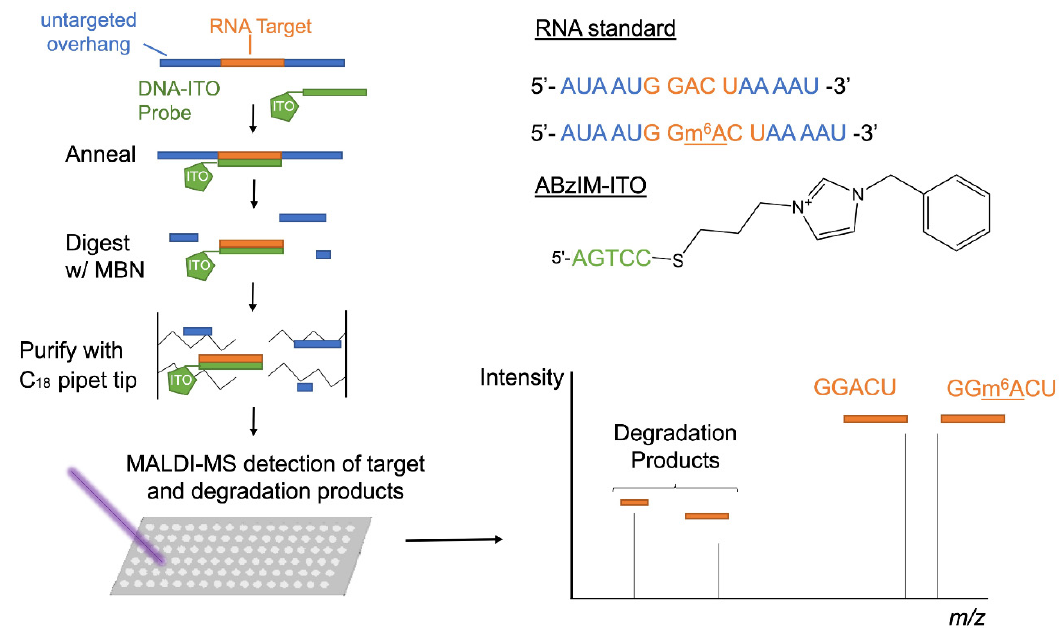
Figure 1. Schematic showing the workflow for the ITO-based nuclease protection assay including ITO probe–target annealing, MBN digestion, sample purification, and MALDI-MS detection of the liberated target sequence (GGACU or GG(m 6 A)CU) and target degradation fragments. liberated target sequence (GGACU or GG(m 6 A)CU) and target degradation